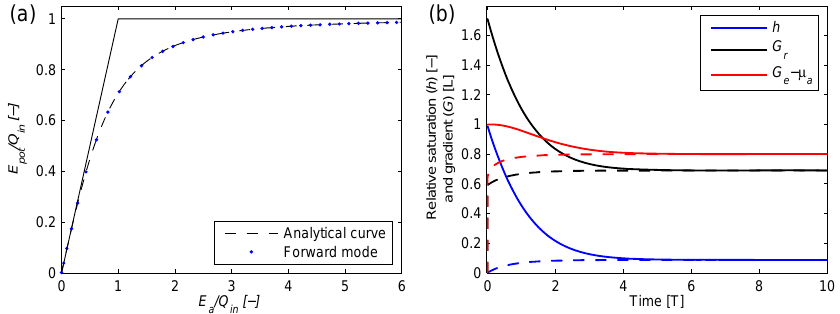
Figure 2. (a) Analytical Budyko curve (Eq. 9) and result from forward mode with constant forcing and (b) time evolution of relative saturation and both gradients for complete initial saturation (solid lines) and initial dry state (dashed lines). µ atm = − 0 .